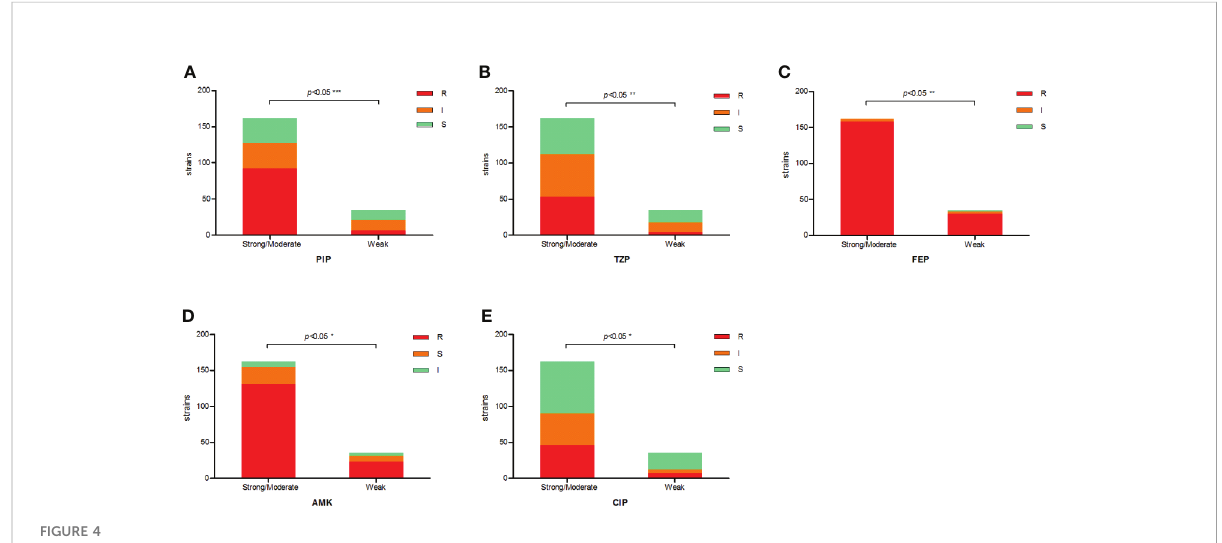
FIGURE 4 The correlation between antibiotic resistance and bio fi lm-forming capacity of clinical E. anophelis isolates to fi ve antibiotics. (A – E) For piperacillin (PIP), piperacillin-tazobactam (TZP), cefepime (FEP), amikacin (AMK), and cipro fl oxacin (CIP). Susceptible isolates tended to form weaker bio fi lms than non-susceptible isolates. Signi fi cant differences were detected between groups. The p-values obtained by Mann – Whitney analysis were as follows: piperacillin (p < 0.0001), piperacillin-tazobactam (p = 0.0088), cefepime (p = 0.0022), amikacin (p = 0.0442), and cipro fl oxacin (p = 0.0461). * means signi fi cant at 0.05 alpha level, ** means signi fi cant at 0.01 level, *** means signi fi cant at 0.001